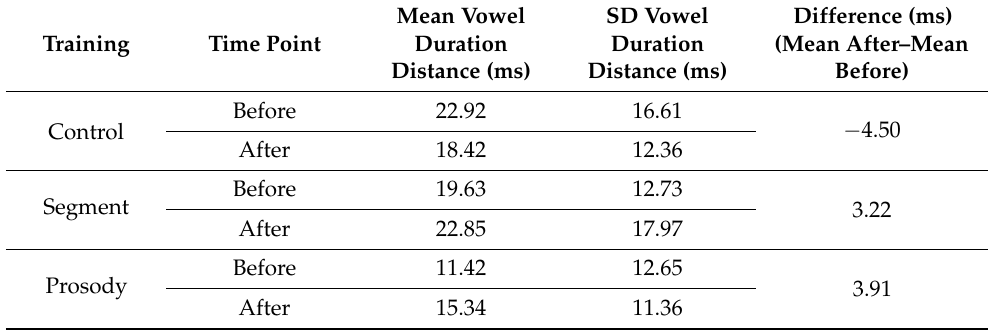
Table 6. Results for vowel duration